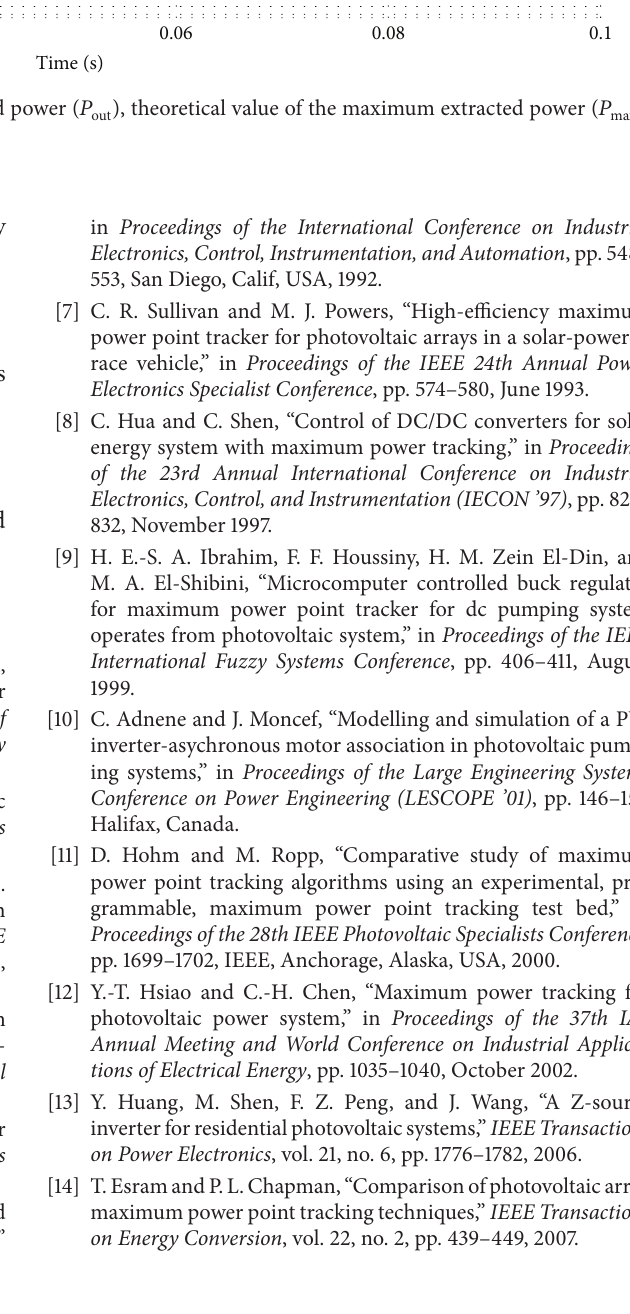
), theoretical value of the maximum extracted power ( 𝑃 max ), out